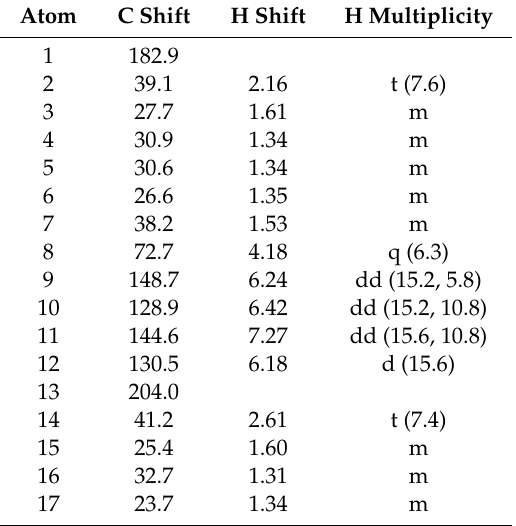
Table 2. The 1 H and 13 C-NMR assignments of compound